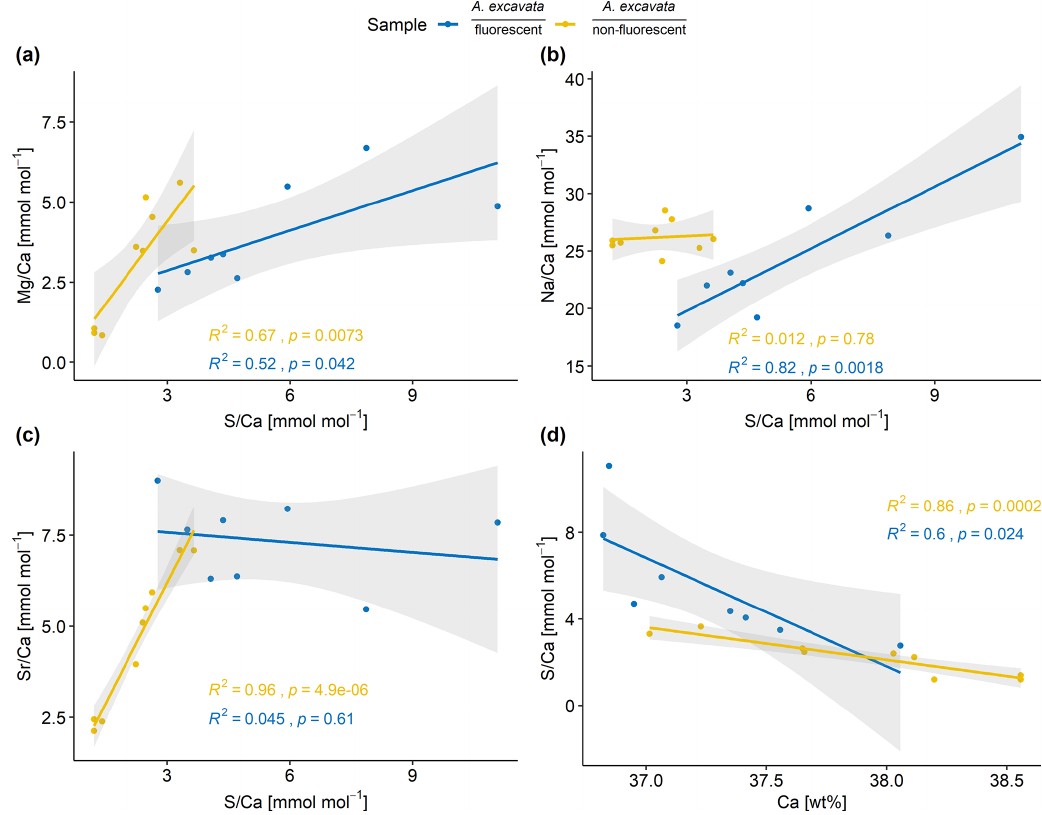
Figure 4. Elemental composition of the SRZ divided according to their fluorescence. Linear correlations are shown for both layers with 95% confidence intervals in gray. Correlations are calculated with a linear regression model with OLS. Table 2. Results of the one-way ANOVA and Kruskal–Wallis analysis with the host organism as predictor variable. Bold fields show elemen- tal and isotopic ratios in H. sarcophaga that may be significantly influenced by the chemistry of the host organism. p values are Bonferroni adjusted, DFn signifies degrees of freedom in the numerator, and DFd signifies degrees of freedom in the denominator. ANOVA Mg / Ca Na / Ca Sr / Ca Mn / Ca δ 18 O δ 13 C DFn 2 DFd 25 F 0.2 0.22 23 0.82 0.029 < 0.001